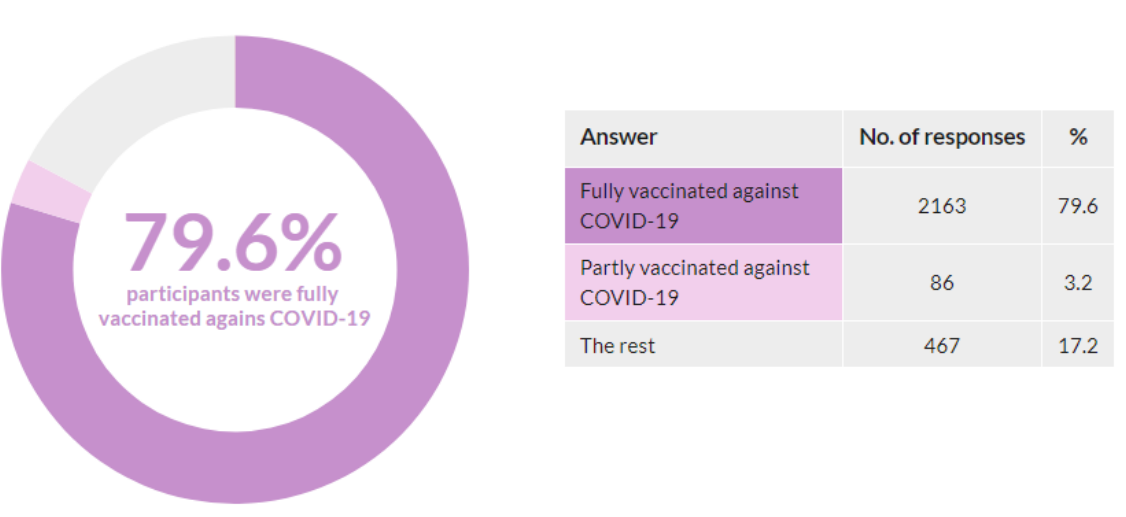
Figure 2. Approach to vaccination, the entire study population, and share of participants vaccinated against COVID-19.